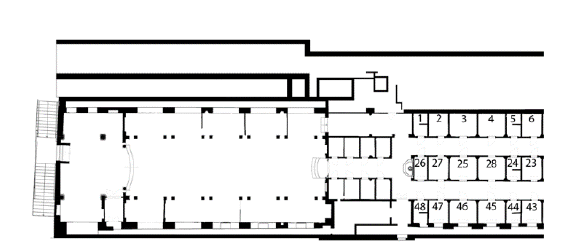
Figure 3. Some images of the Albergo Diurno di Porta Venezia (Milan, Italy).